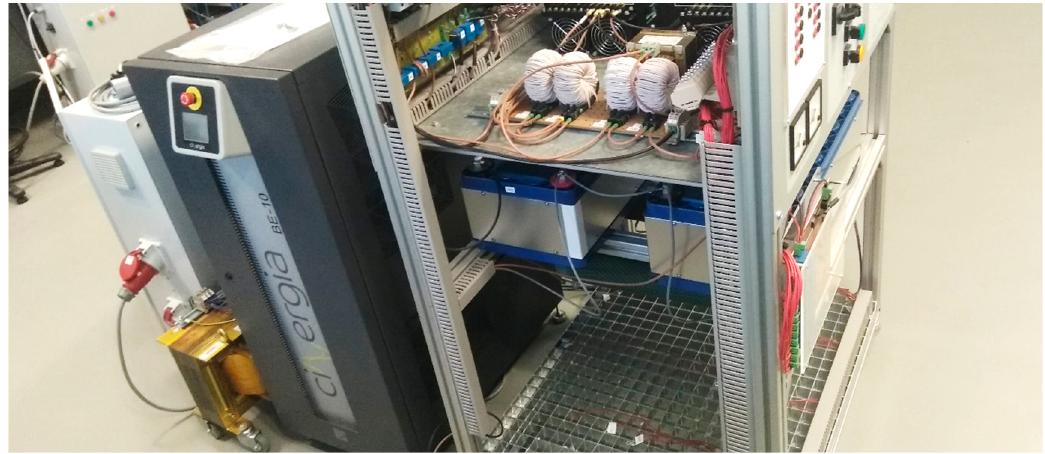
Figure 19. S upercapacitors (centre) and CINERGIA Battery Emulator (left). Figure 19. Supercapacitors (centre) and CINERGIA Battery Emulator (left).